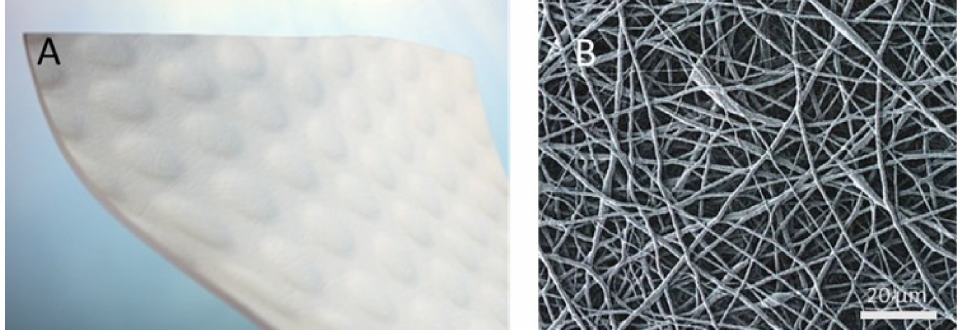
Figure 2. Synthetic hybrid-scale fiber matrix—( A ) representative image of gross appearance and ( B ) scanning electron microscopy